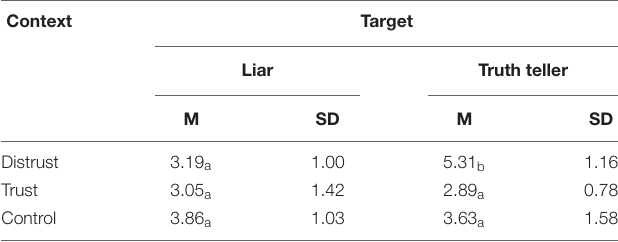
TABLE 2 | Means and standard deviations of participants’ judgments of the targets’ deception, as a function of context and target for Study 2 (the higher the scores, the more deceitful, 1 = totally not deceitful, 7 = very much deceitful).